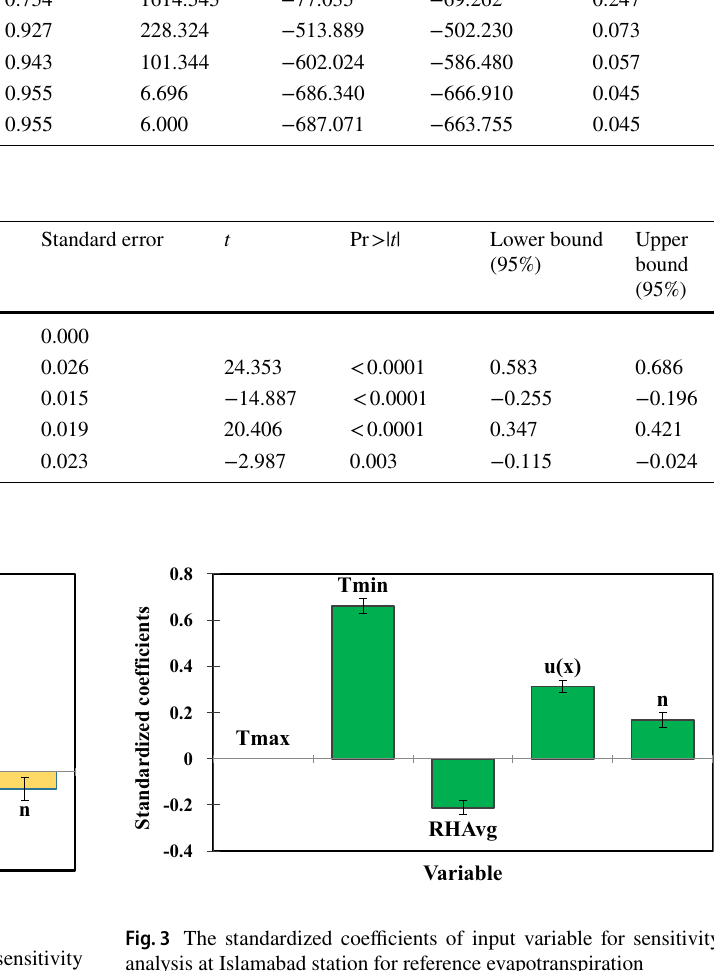
Table 3 The best subset regression analysis for determining the best input combinations at Islamabad station No. of Variables variables